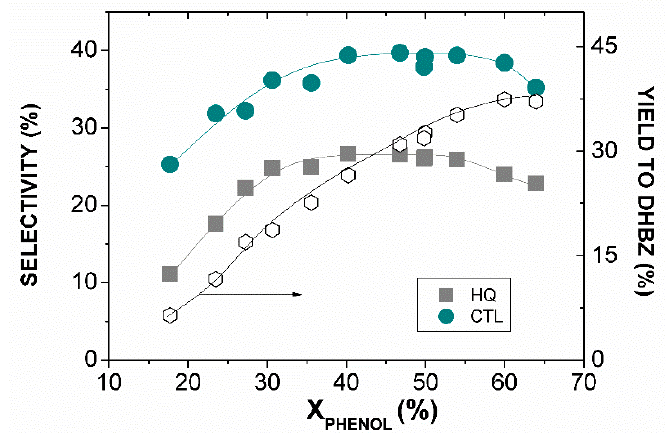
Figure 5. Results of the hydroxylation of phenol over Fe-BTC with H 2 O 2 dosage. Operating conditions: [Phenol] 0 =0.35 mol L − 1 , phenol:H 2 O 2 = 1:1, T = 25 °C, W FeBTC = 0.01 g.